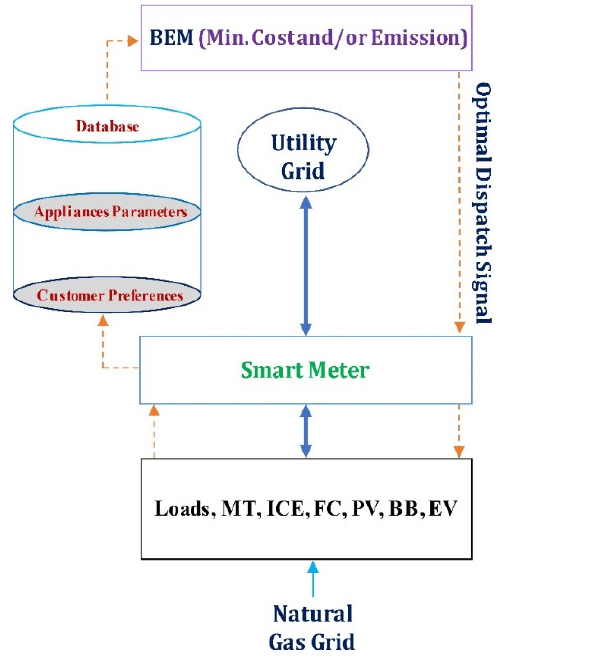
Fig. 3: Implementation details of proposed